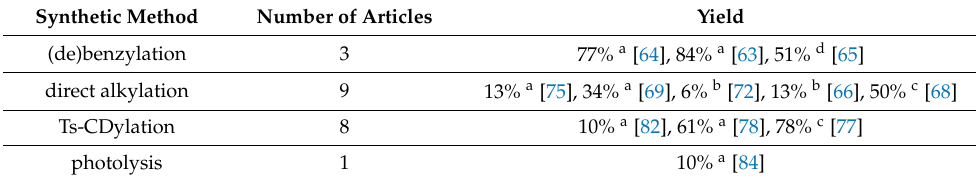
Table 3. Preparation of 6 A - O -aryls/alkyls of CDs. Synthetic